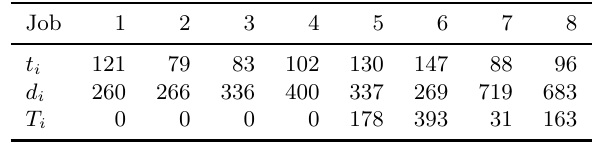
Table 1: MDD schedule processing times, due dates and tardiness